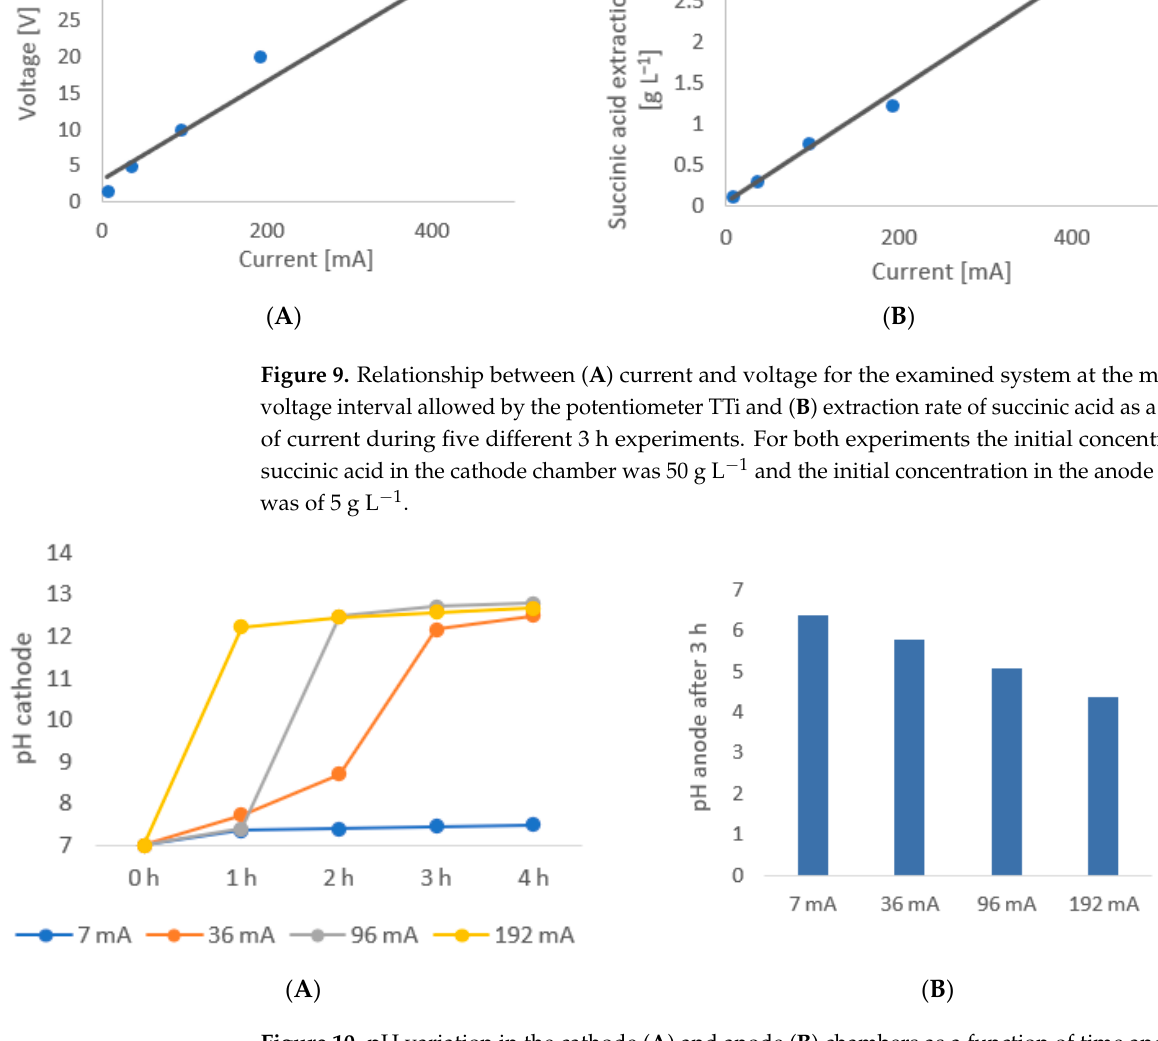
Figure 10. pH variation in the cathode ( A ) and anode ( B ) chambers as a function of time and current for a solution of succinic acid of initial concentration 50 g L − 1 in the cathode and 5 g L − 1 in the anode chambers. The variation at the anode side is the result of production of hydroxide ions from electrolysis while the variation in the anode chamber is the result of release of H + ions from water electrolysis.